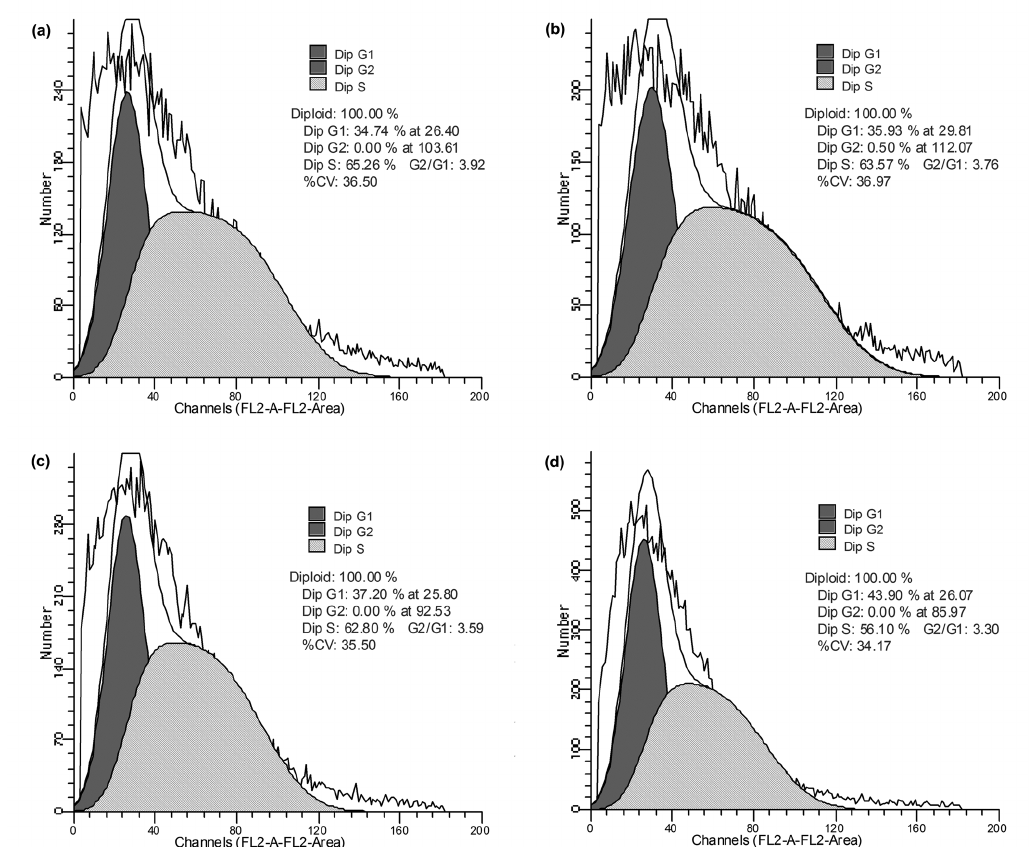
Fig. 6: Effect of bioassay-guided fraction from Athyrium sinense (PA) on cell cycle of Clavibacter michiganensis subsp. sepedonicus (Cms). Cms cells were treated with 0.80% DMSO (control, a); Cms cells were treated with PA at the concentration of 0.05 mg mL -1 (b); Cms cells were treated with PA at the concentration of 0.10 mg mL -1 (c); Cms cells were treated with PA at the concentration of 0.15 mg mL -1